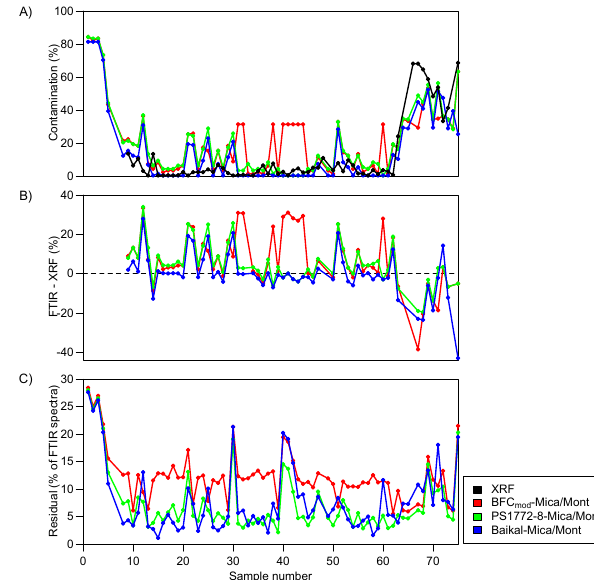
Fig. 7. FTIR three end-member (diatom, mica and montmoril- lonite) results: (A) FTIR and XRF estimates of contamination in Lake Baikal samples; (B) FTIR minus XRF estimates of contamina- tion. Positive/negative values indicate FTIR over/under-estimation of sample contamination; (C) Residuals ( Residual c ) from the fit- ting of the sample FTIR spectra against the best-fit modelled FTIR spectra. No XRF results for some samples indicates the absence of sufficient material for XRF